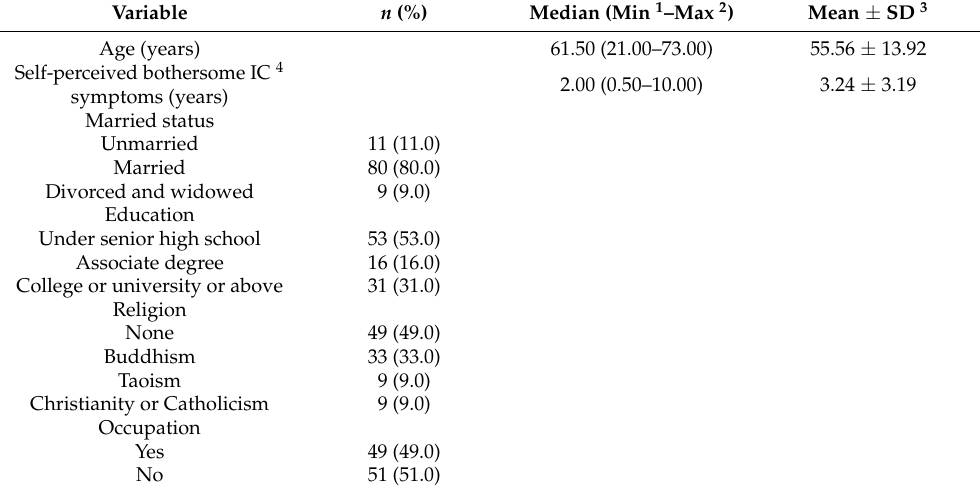
Table 1. Participant characteristics ( N =